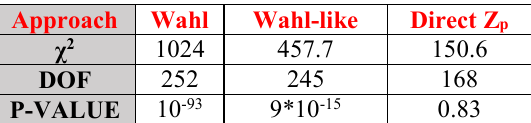
Fig. 12. Empirical standard deviation of post-neutron charge distributions calculated from the JEFF-3.1.1 library (green) compared to those from the direct-Zp approach (blue). Table 1. Statistical test of charge distribution according to the different Zp parametrizations.